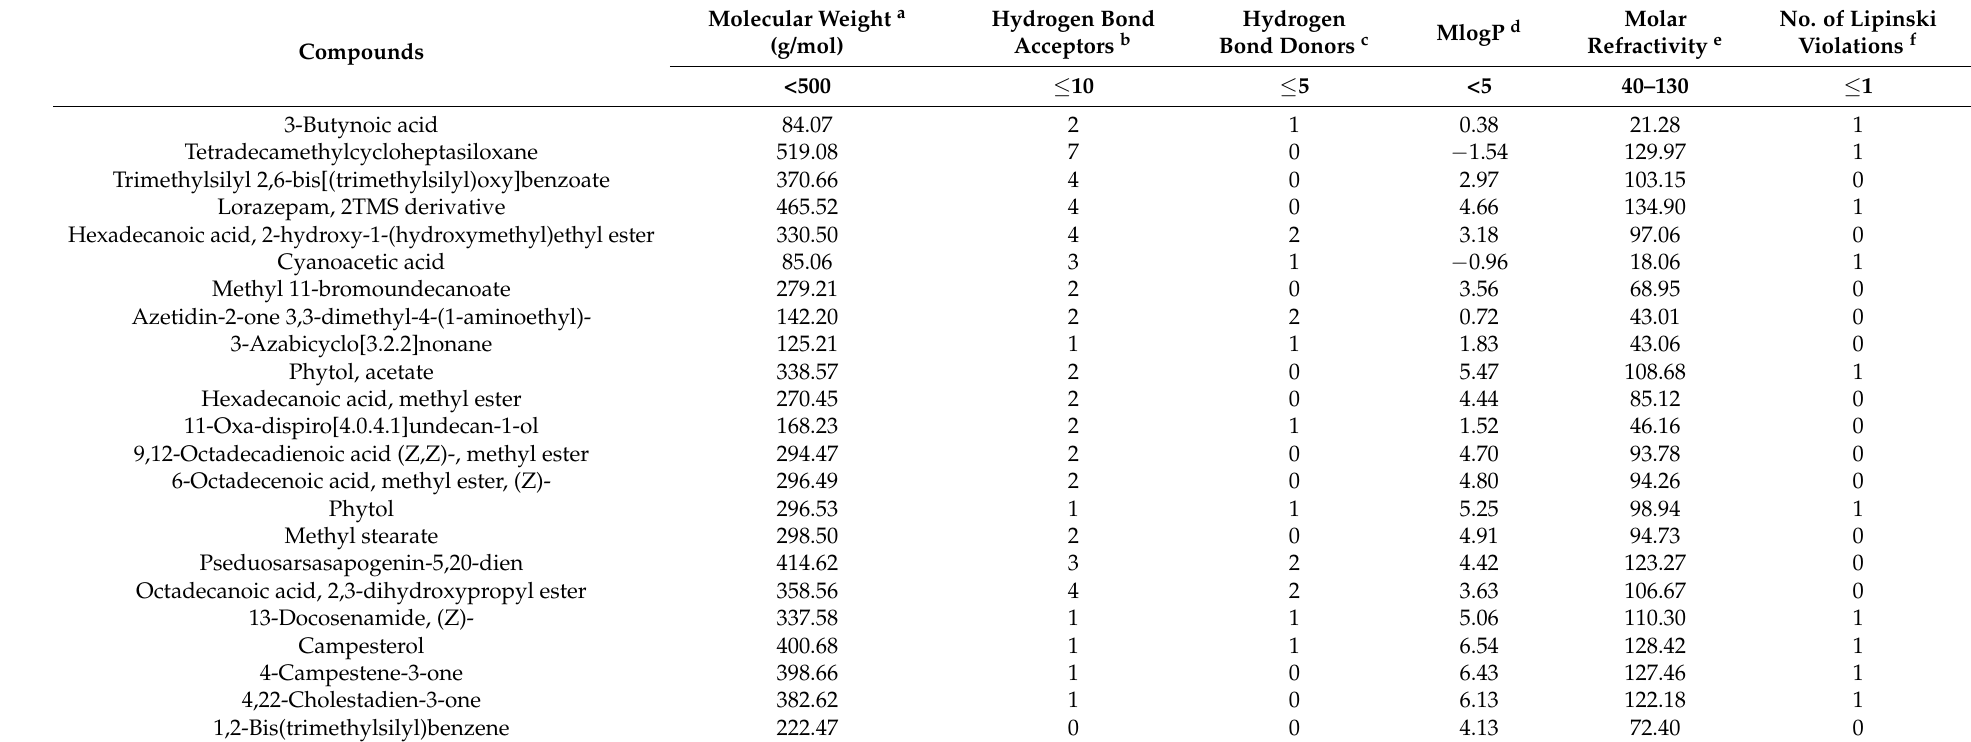
Table 3. Pharmacological profile of the 23 ligand molecules passing the Lipinski’s RO5, as derived from the SwissADME webserver.